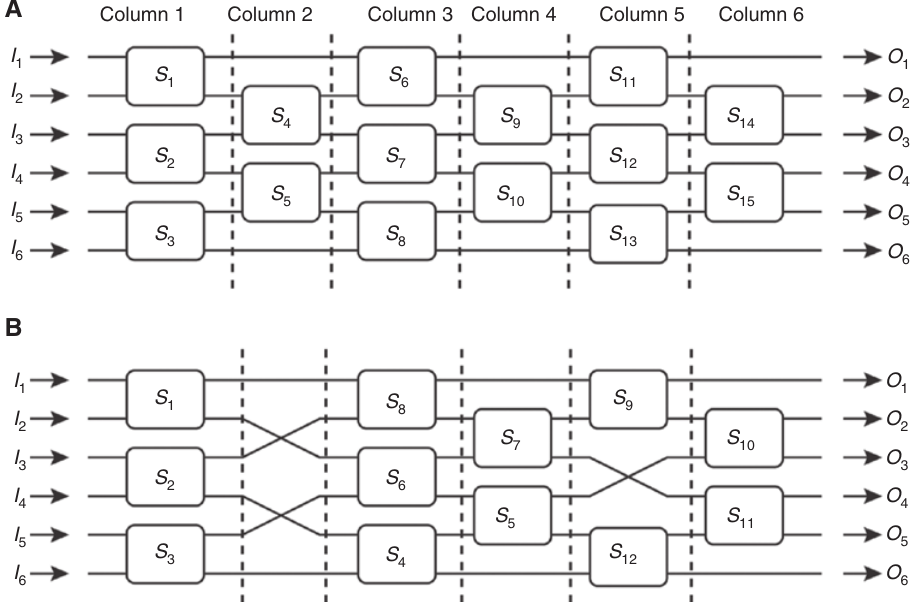
Figure 1: Rectangles represent the optical switching units. Both (A) and (B) have identical connectivity. (A) Architecture of six-port optical switch based on typical Spanke-Benes architecture and (B) architecture of the optimized six-port optical